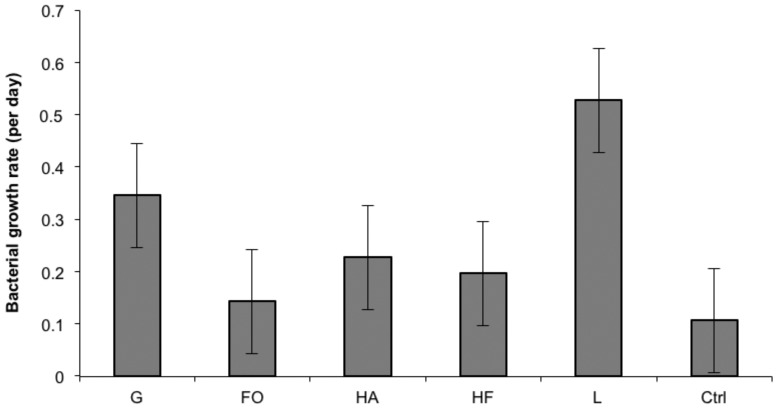
Growth rate of a marine bacterial community on different carbon sources.G = Glucose, FO = Fulvic acid isolated from the Öre river, HA = Humic acid (Aldrich), HF = Humic acid (Fluka), L = Lactose, Ctrl = Control (seawater). Error bars are standard error (n = 3).